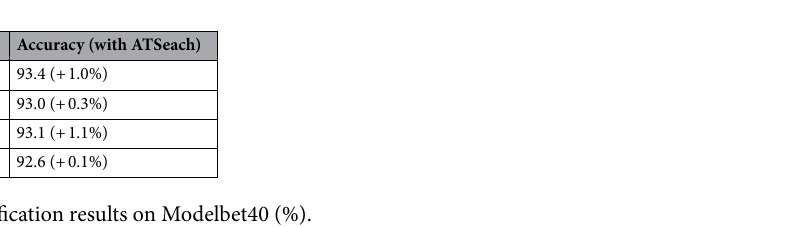
Table 1. Shape classification results on Modelbet40 (%).